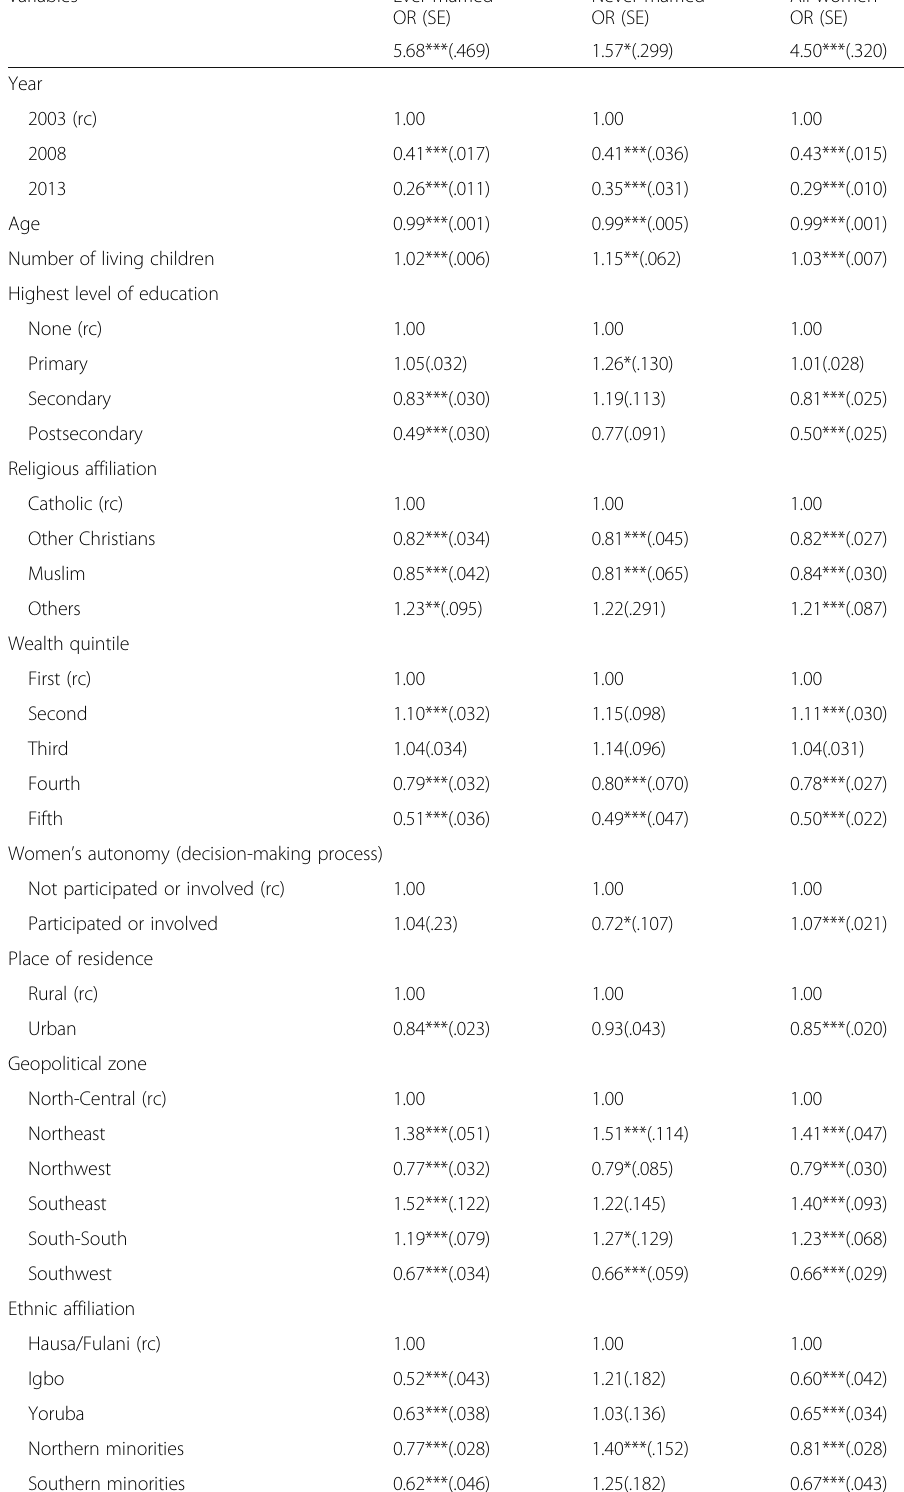
Table 3 Multivariate odds ratio of assessing demographic and socioeconomic characteristics on agreement with wife-beating by husbands among Nigerian women, 2003, 2008, and 2013